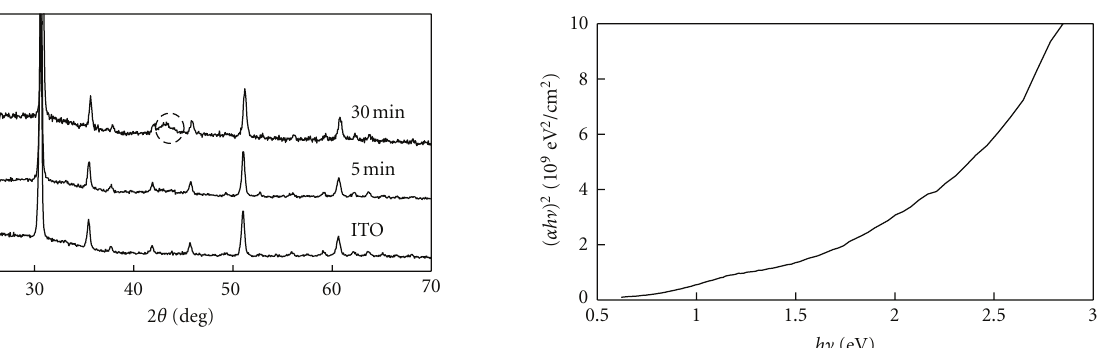
Figure 5: XRD spectra for the CTSO films deposited under condition 1 with di ff erent deposition time (5min and 30min). A broad peak near 2 θ = 43 ◦ observed for the 30 min deposition sample (the circle in the figure) can be attributed to the CTSO film, and all other peaks are due to ITO.